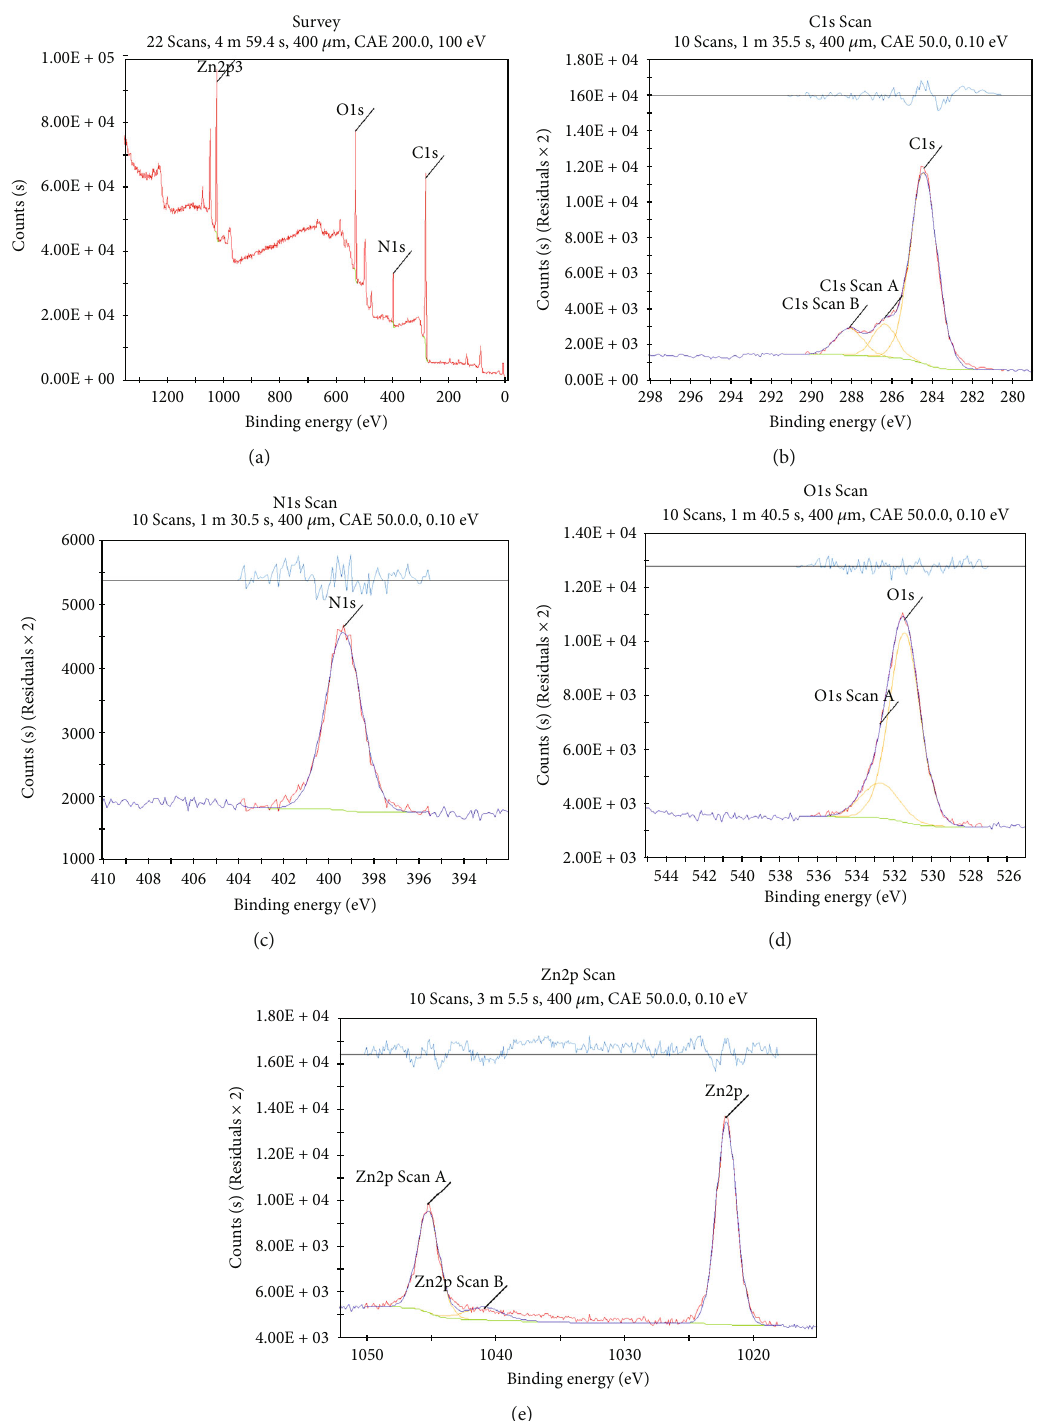
Figure 4: XPS spectra of the fabricated Zn-adeninate bio-MOF; (a) full spectrum, (b) C 1s spectrum, (c) N 1s spectrum, (d) O 1s spectrum, and (e) Zn 2p